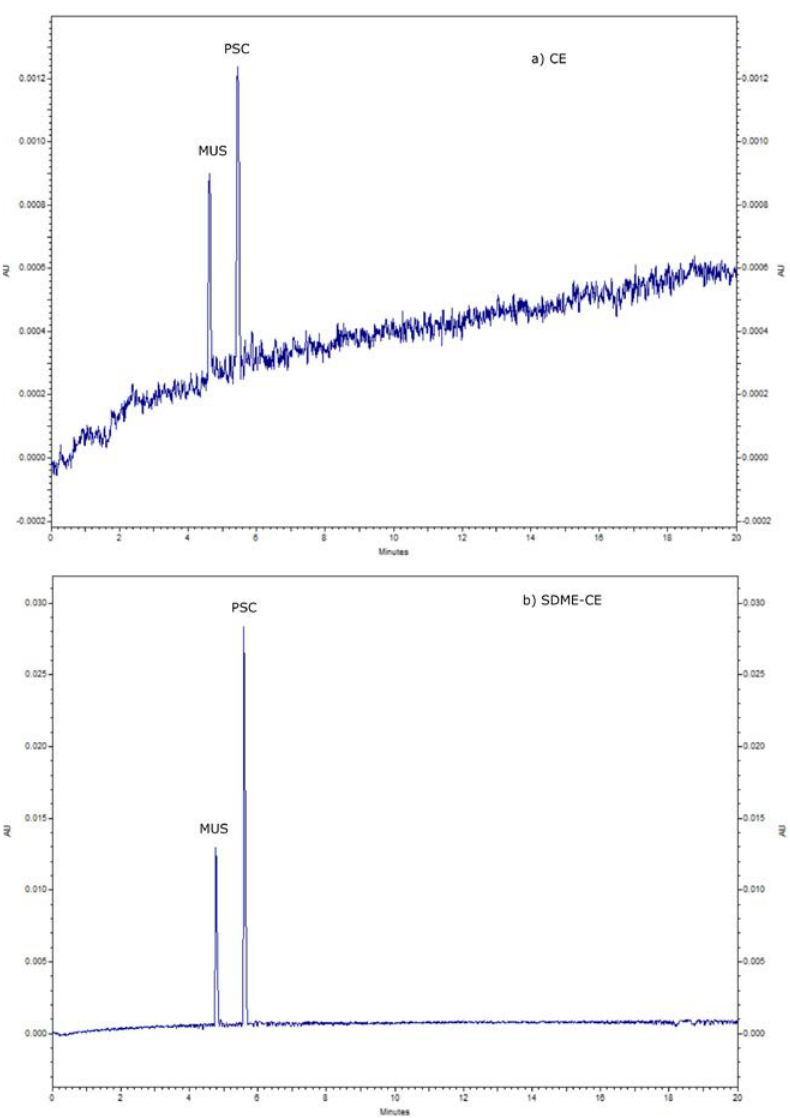
Figure 3. Electropherograms of 25 mg L − 1 aqueous samples of standards (PSC and MUS) during CE